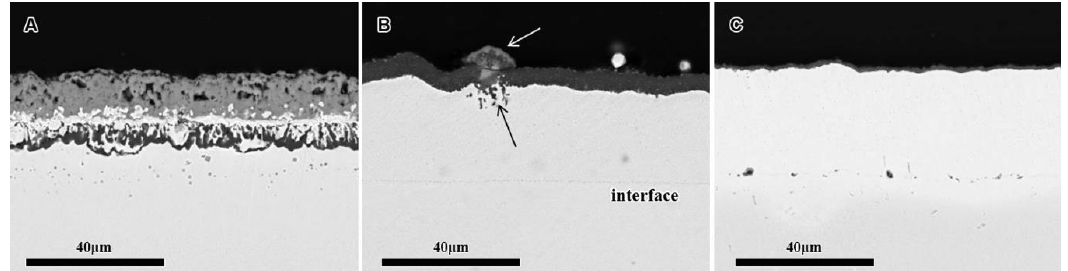
Figure 5. Cross-section morphologies of specimens in three groups after oxidation at 1050 °C for 100 h in air: ( A ) K38 superalloy; ( B ) SN-K38 nanocrystalline coating; ( C ) SN-N5 nanocrystalline coating.